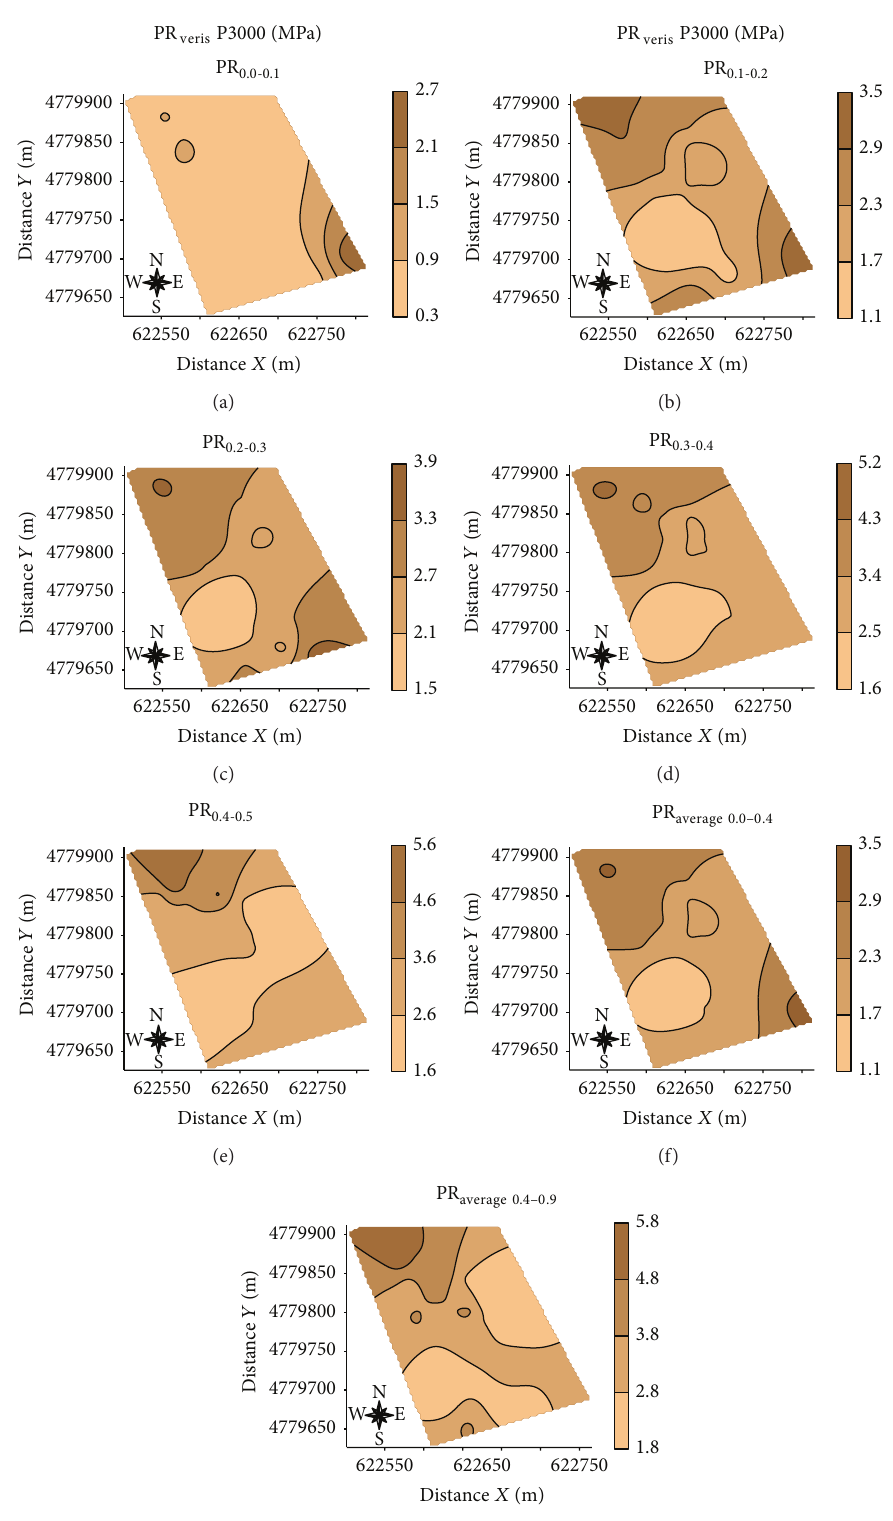
Figure 6: Maps of soil resistance to penetration measured with the penetrometer Veris (PR 0.0 , and PR ) obtained by universal PR 0.0 – 0.4 average average 0.4 – 0.9